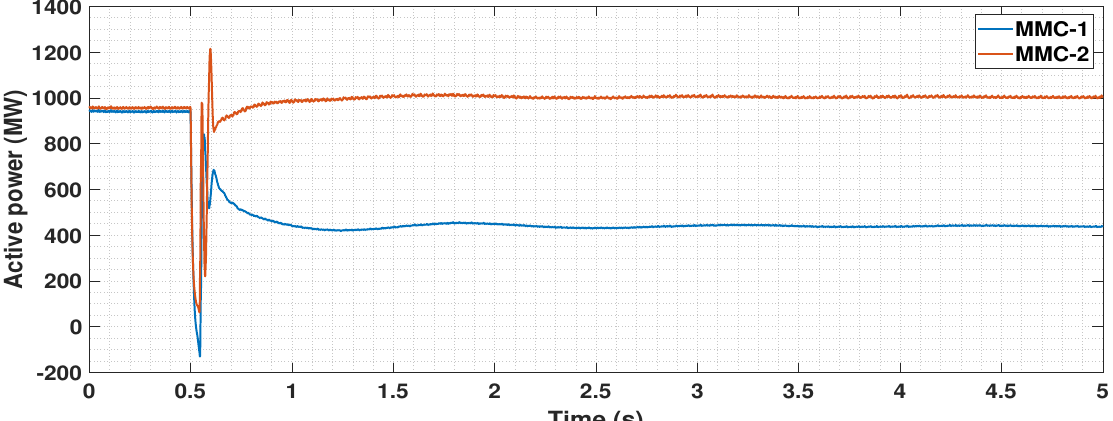
Figure 32. Active power in MMC-1 bus and MMC-2 bus upon three-phase line to ground fault in the middle of cable-1.